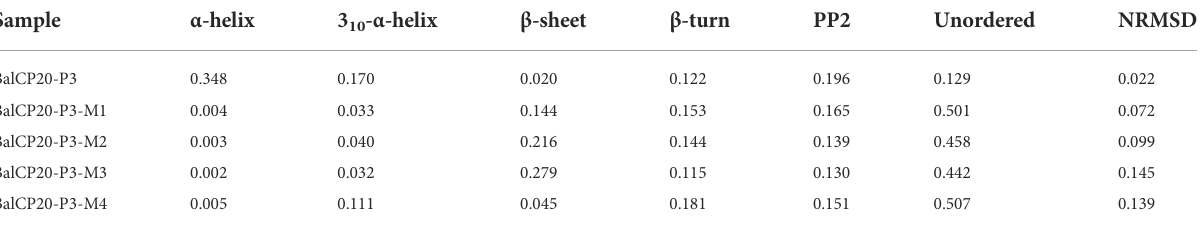
TABLE 1 Secondary structure ratios of BalCP20-P3 and its mutants. Sample